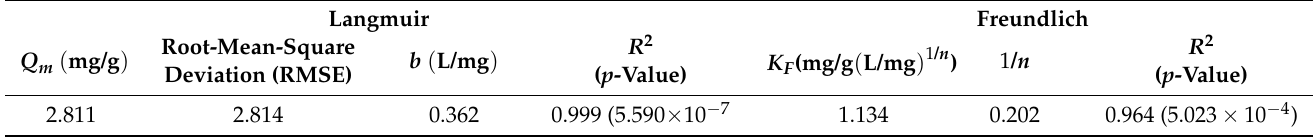
Table 1. Correlation coefficients and isotherm parameters for adsorption of RB5 on UBC. Langmuir Freundlich